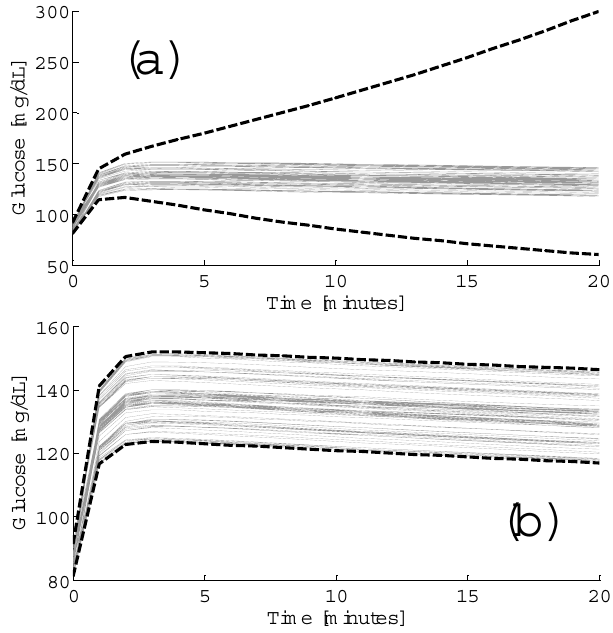
Fig. 3. Output bounds for the linear glucose model developed by Cobelli et al. (a) Monotonicity approach. (b) Using lemma IV.1. The black dashed lines in Figure 3 display the com- puted output bounds, while the light grey lines represent several numerical simulations executed by the variation of the parameters and initial conditions values.